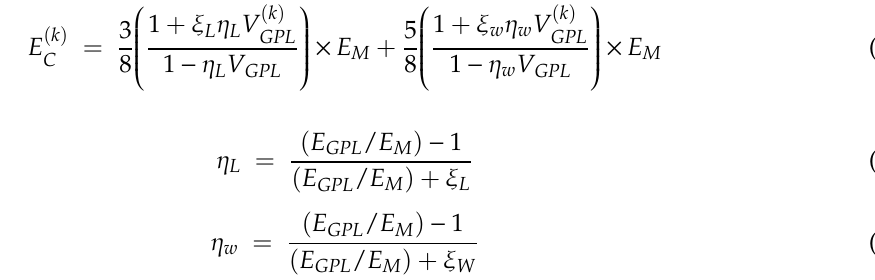
Figure 2. Di ff erent patterns of multi-layer GPL / polymer Figure 2. Different patterns of multi ‐ layer GPL/polymer nanocomposite.